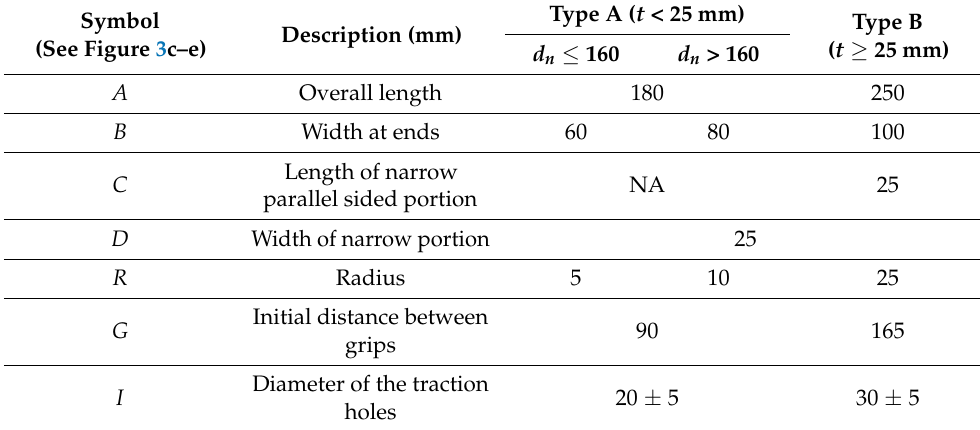
Table 2. Dimensions of WT specimens per ISO 13953.